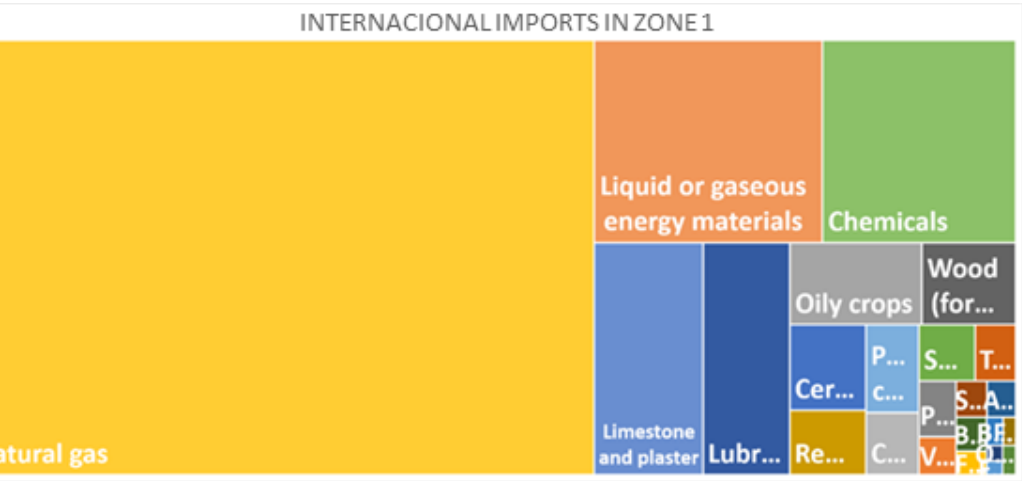
Figure 4. Graphical example of the international imports calculated by REMET-UA mode [23].